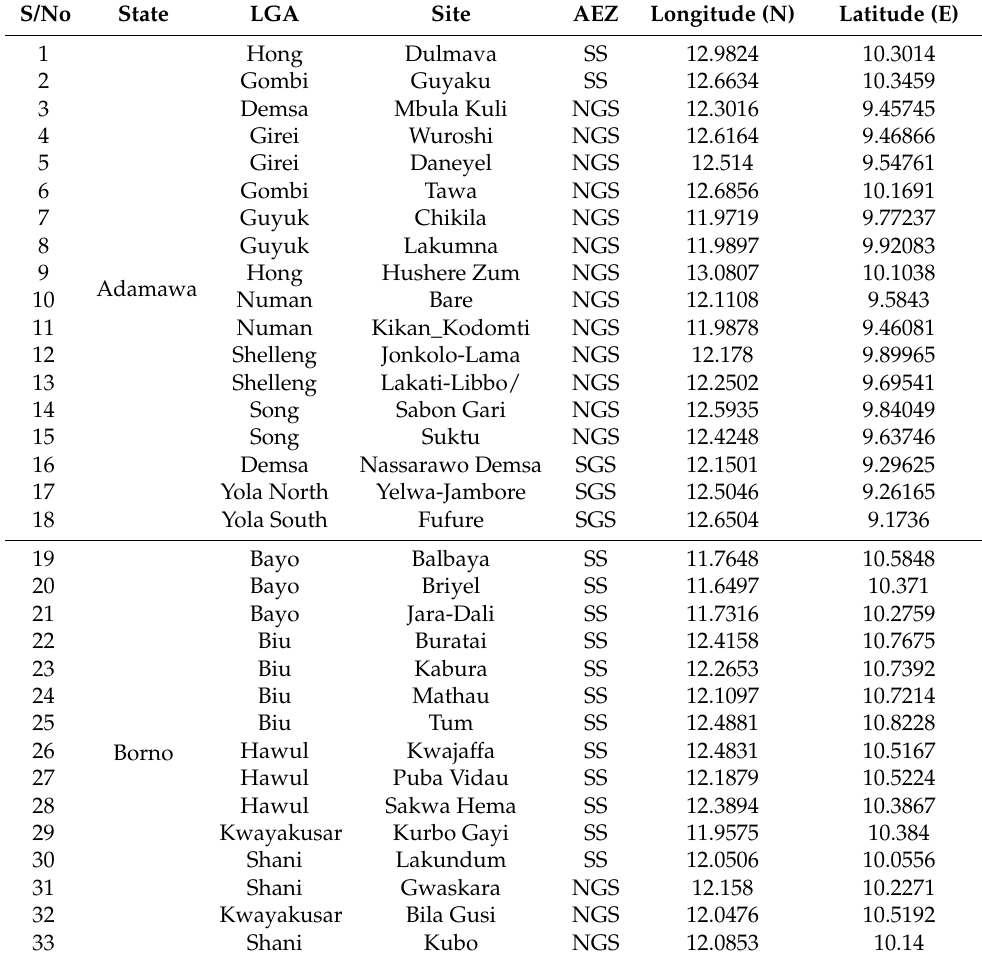
Table 2. Summary of the selected sites for model application of sorghum cultivars under varying planting